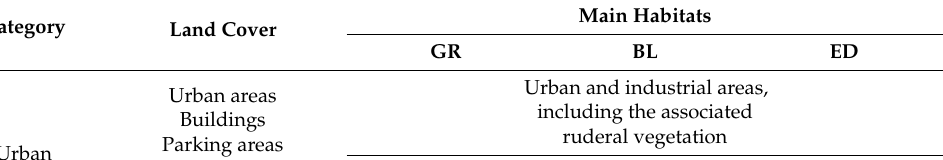
Table S1: Projected surface (Ha) under the TDA and CA for di ff erent SLR scenarios at 2050 and 2100 in the GR. Table S2: Projected surface (Ha) under the TDA and CA for di ff erent SLR scenarios at 2050 and 2100 in the LD. Table S3: Projected surface (Ha) under the TDA and CA for di ff erent SLR scenarios at 2050 and 2100 in the ED.